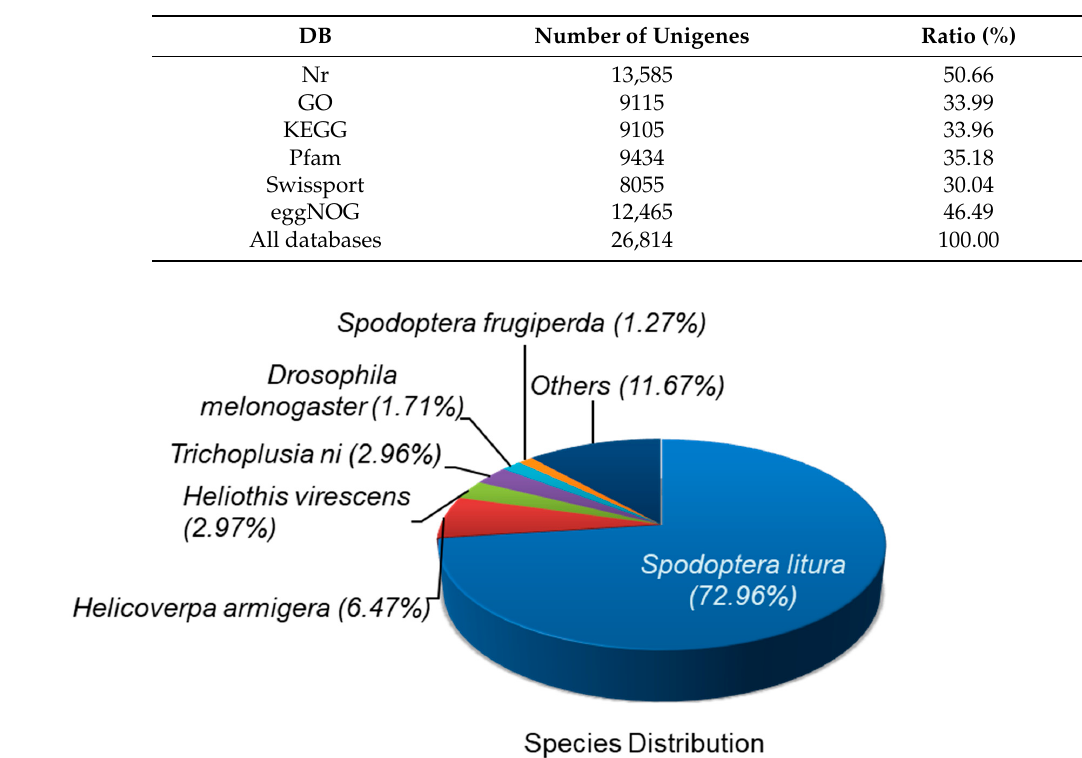
Figure 1. De novo transcriptome analysis of unselected and Noposion Yihaogong ® 5% EC insecticide-exposed larvae. Pie chart showing the result from annotation gene ontology annotation and classification of the Spodoptera frugiperda transcriptome.